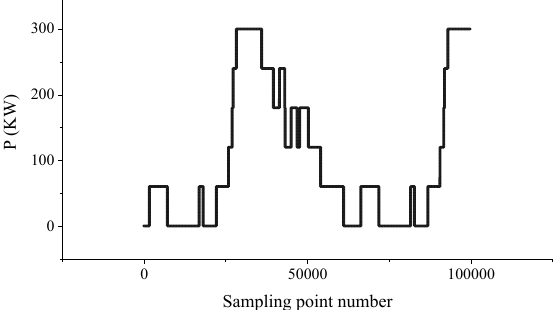
Figure 17. Evaluation of power controllability of electric vehicle charging station.